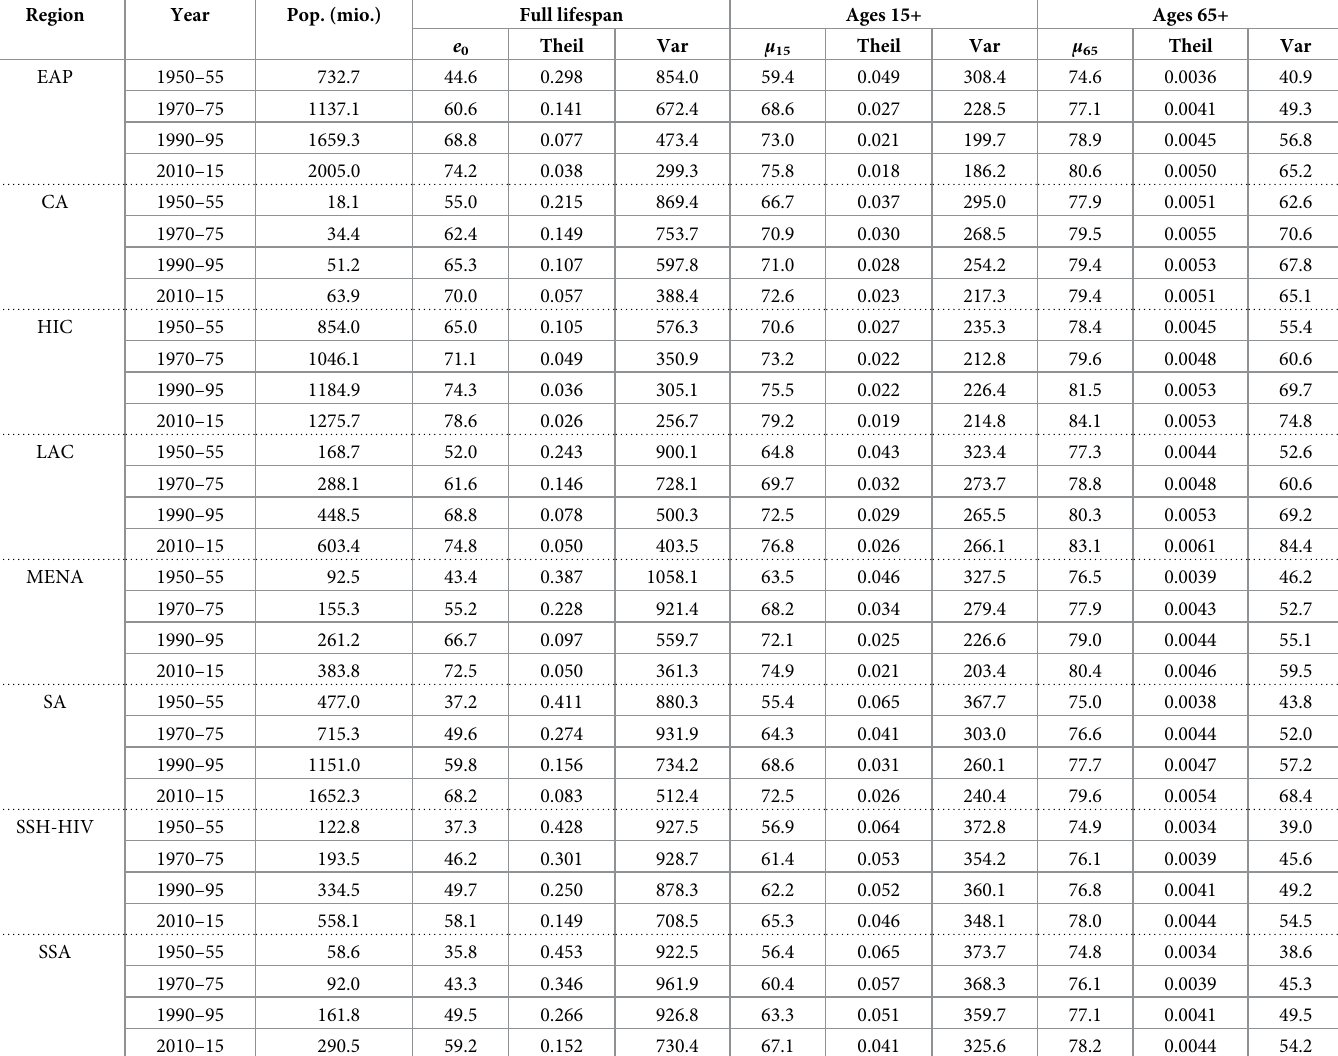
Table 1. Regional indicators of longevity and lifespan inequality for unconditional and conditional age-at-death distributions. Region Year Pop.